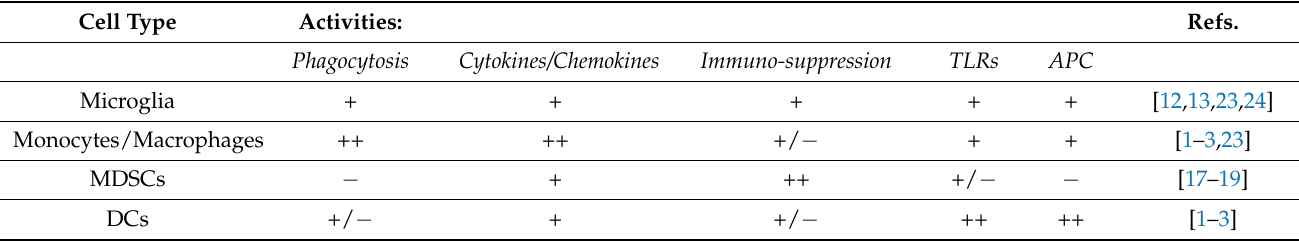
Table 2. Impact of Myeloid Cell Populations in GBM.